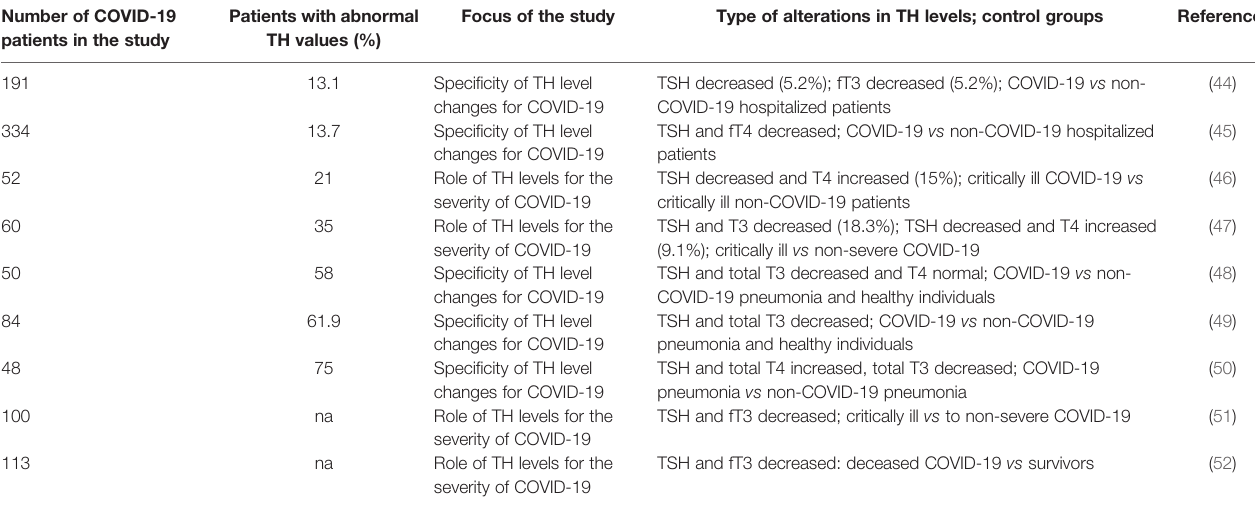
TABLE 1 | Overview of studies on prevalence and relevance of thyroid dysregulation in COVID-19. Number of COVID-19 Patients with abnormal Focus of the patients in the study TH values (%)